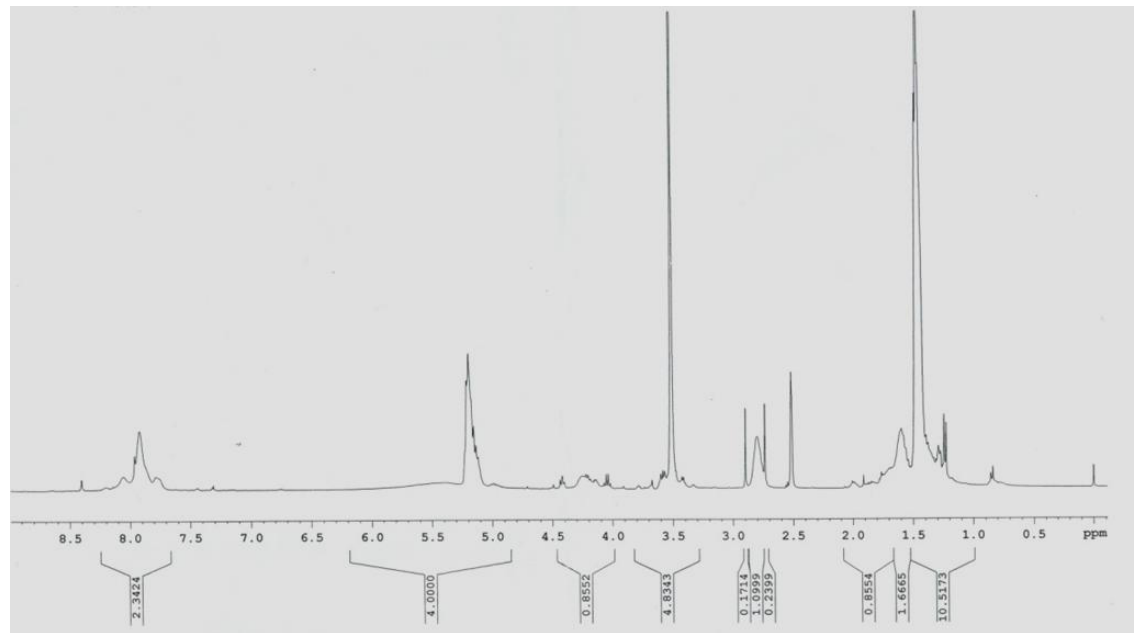
Figure 1. The 1 H NMR spectra of